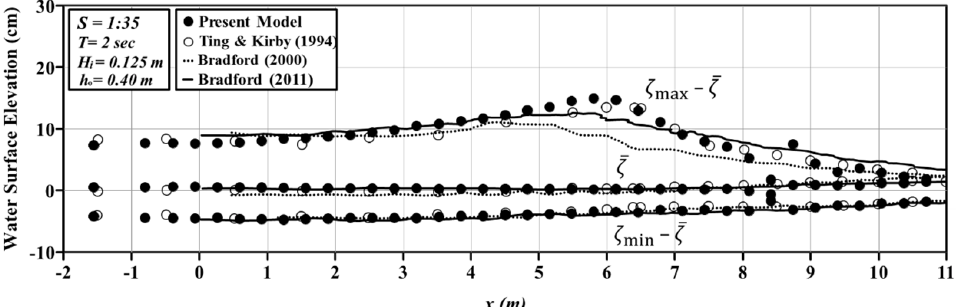
Figure 2. Spatial variation in the surface elevations of the maximum water level ( ζ max − ζ ), mean water level ( ζ ), and minimum water level ( ζ min − ζ ), as a periodic wave propagates on the slope seawall. ( ● ) The results of present numerical model; ( ○ ) experimental data ([4]); (···) numerical re- sults ([36]); (-) numerical results ([37]).